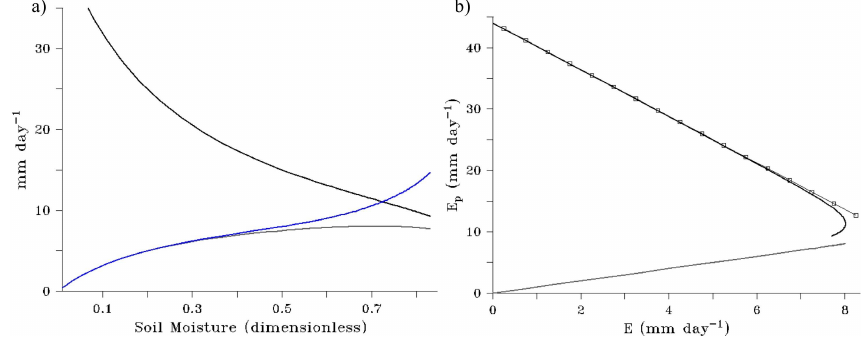
Figure 1. Complementary relationship in the baseline configuration. (a) Potential evapotranspiration ( E p ; black), evapotranspiration ( E ; gray), and precipitation ( P ; blue) as functions of soil moisture ( w ). (b) E p vs. E (black) and the 1 : 1 line (gray). Also shown is the best fit linear regression of the E p to E relationship (squares).